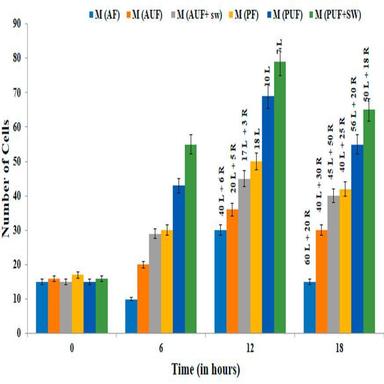
Cohnilembus sp. growth in coral mucus. Cohnilembus sp. cells were placed in the substrate containing Acropora and Porites mucus for its growth analysis. The ciliate cell numbers (trophont/adult stage) were found high with Porites mucus unfiltered (M (PUF) added with sea water and Porites mucus filtered (M (PF) added with sea water. In contrast, the poor or negligible increase in ciliate cell numbers was observed in conditions with Acropora mucus filtered (M (AF) and mucus unfiltered (M (AUF), but the thero